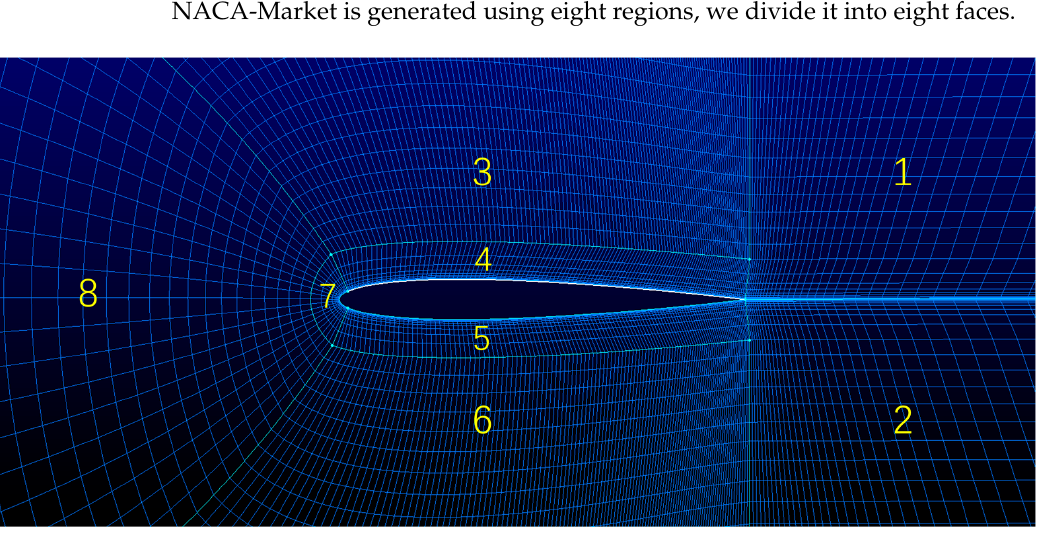
Figure 9. Geometric model and topology of the airfoil mesh. 1, 2, 3, 4, 5, 6, 7, 8 correspond to the eight zones of the division.